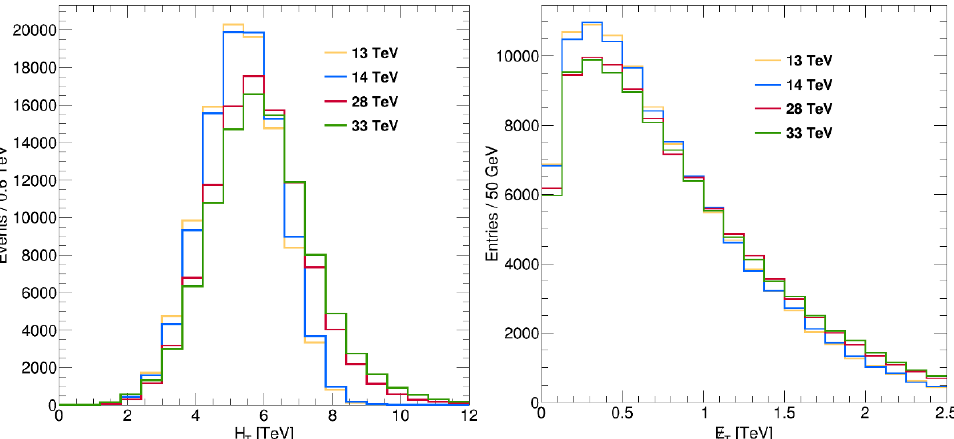
of events in simulated LHC collisions T